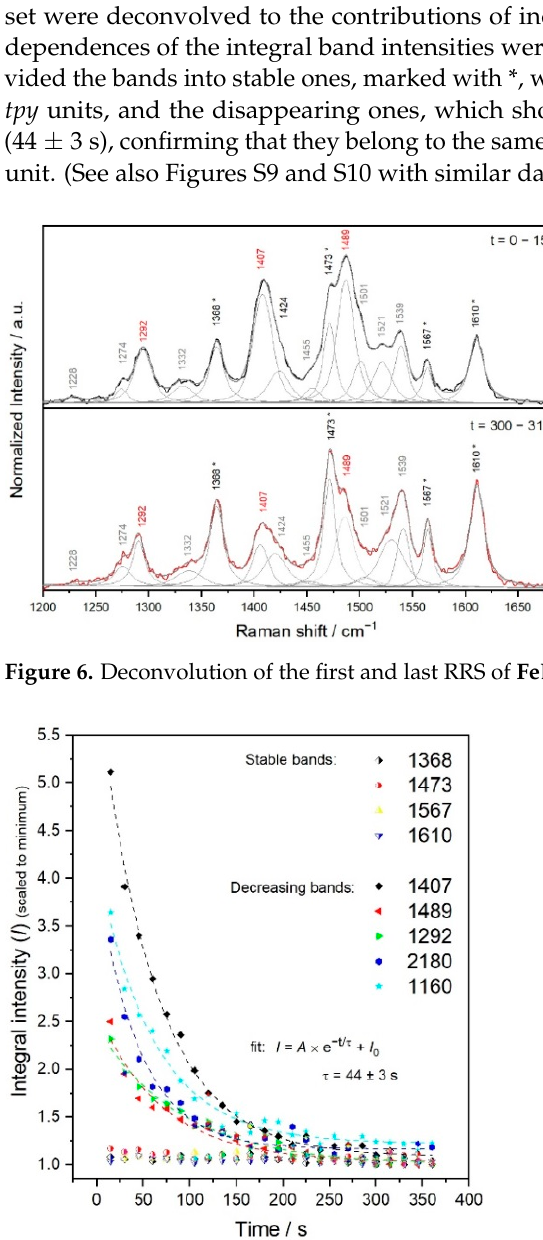
Figure 7. Time evolution of individual Raman bands of FeET exposed to the excitation radiation.